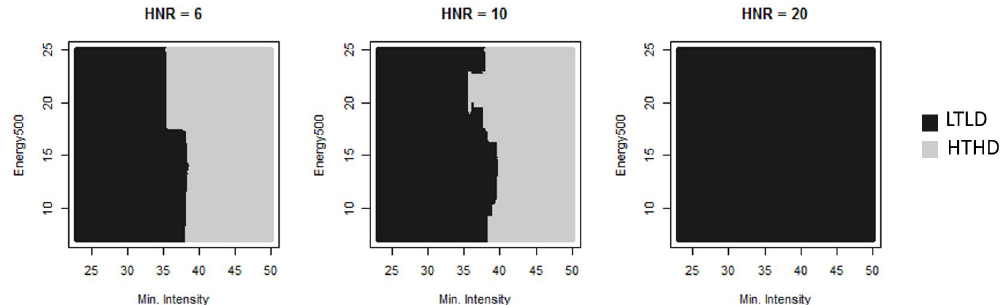
Fig 3. Visualization of all decision trees in the RF, for energy levels in the 250-750Hz band, relative to minimum intensity and HNR. Each dot indicates a decision tree’s classification. HTLD and LTHD do not appear, indicating the combination of the three features were not significantly associated to those